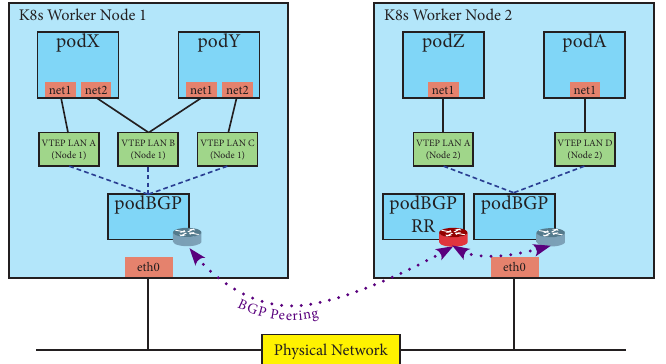
Figure 3. The Megalos networking